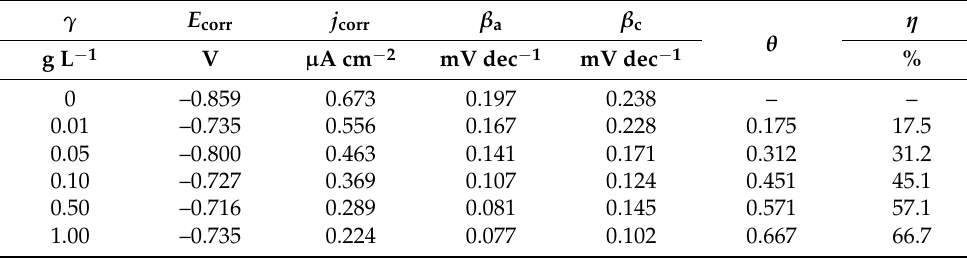
Table 4. Kinetic parameters from polarization measurements and calculated values of surface coverage, θ , and inhibition efficiency, η , for the Al 5083 alloy in ASW without and with the addition of different concentrations of Artemisia annua L. extract